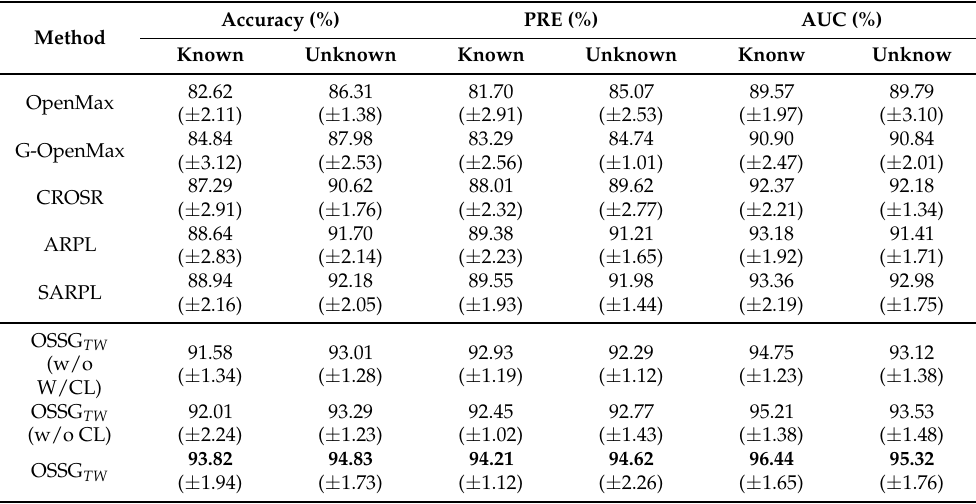
Table 1. The results of the